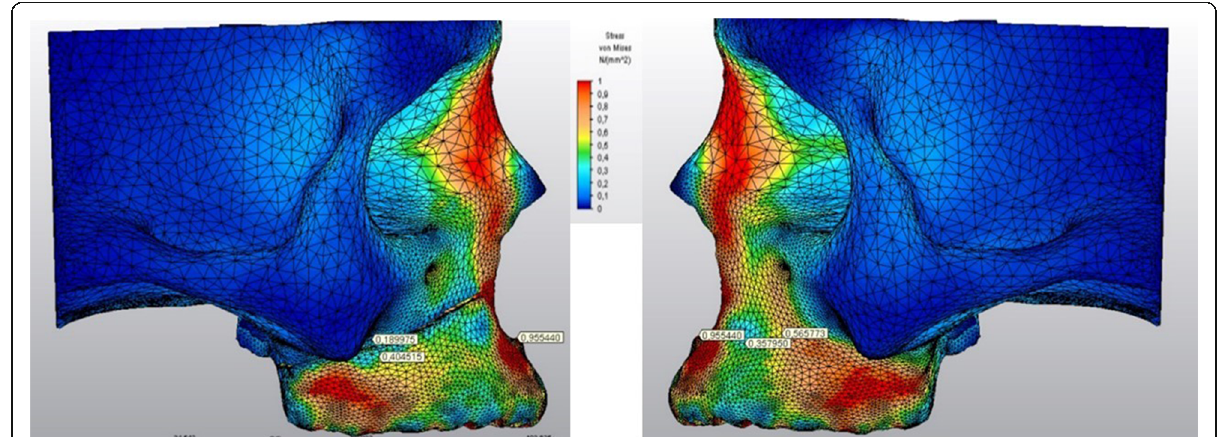
Fig. 7 Lateral views of the stressed areas in the corticotomy applied (left) and non-corticotomy sides